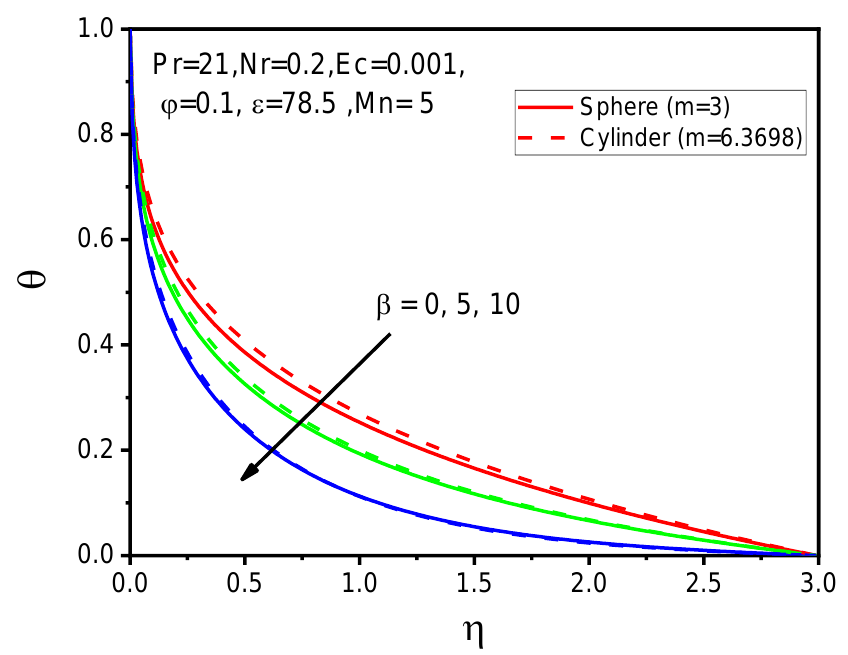
' F for 510 ,  = against